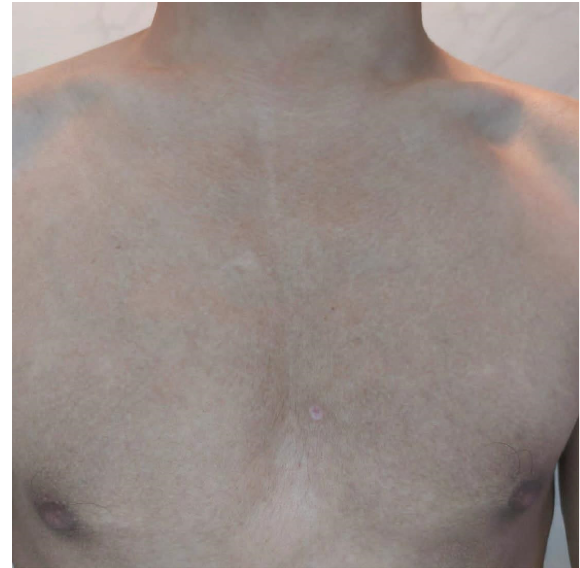
Figure 4: No recurrence at two-month